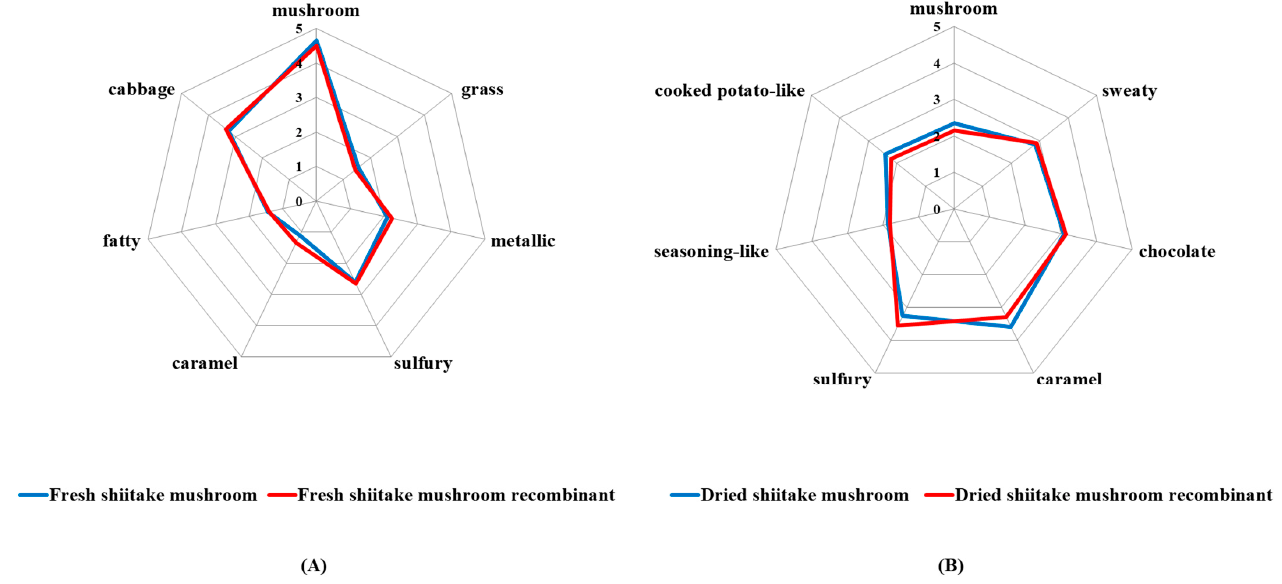
Figure 1. Aroma reconstitution models of fresh ( A ) and dried ( B ) shiitake mushrooms.